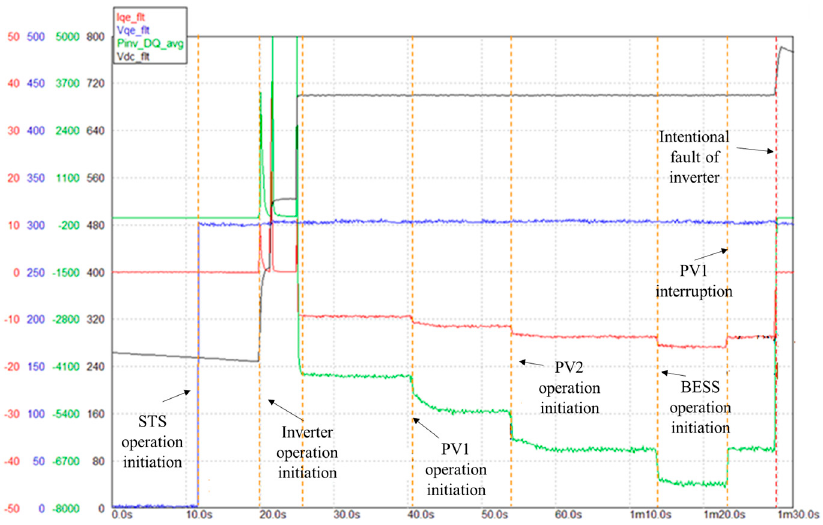
Figure 9. Test sequence.